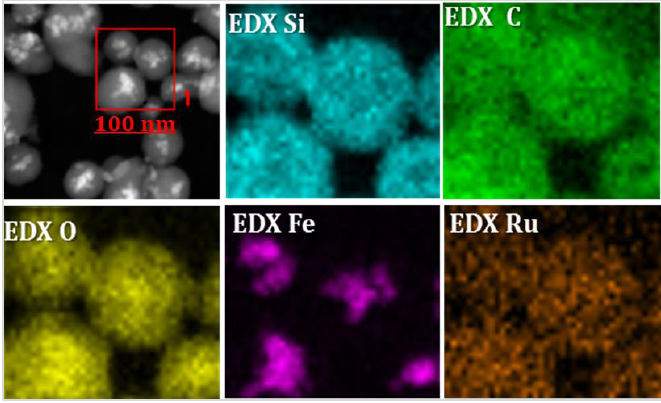
Figure 12. STEM-EDX mapping analysis of Ru@M-Ethylene PMO NPs.